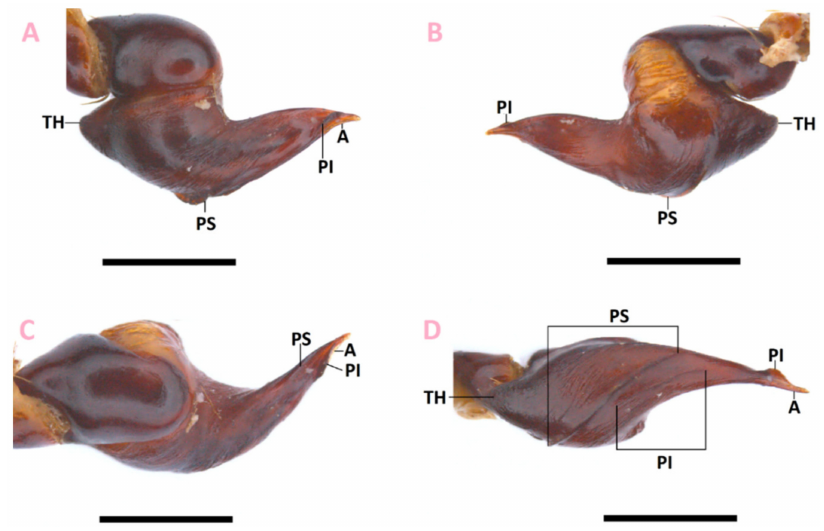
Figure 1. Thrixopelma nadineae sp. nov. holotype male (ZMH-0000888), palpal bulb (left hand side), ( A ) prolateral view, ( B ) retrolateral view, ( C ) dorsal view, ( D ) ventral view. Scale bars = 1